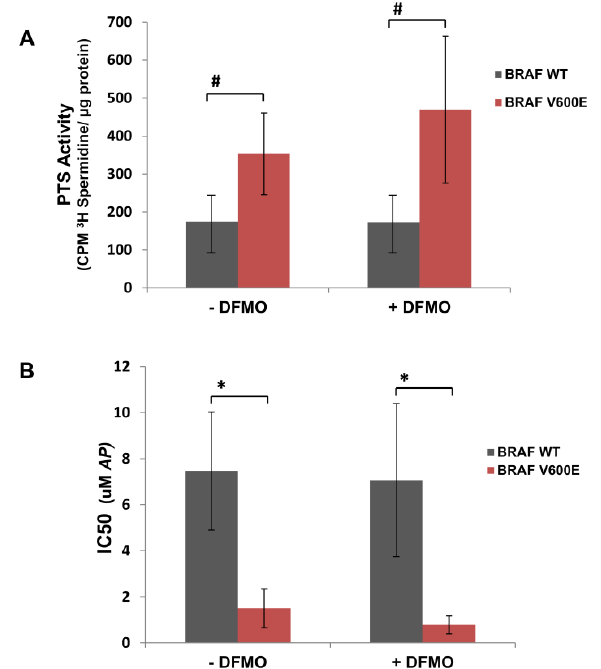
Figure 2. Greater PTS activity and increased sensitivity to AP in mutant BRAF V600E human melanoma cells compared to wild type (WT) BRAF WT cells. ( A ) BRAF V600E human melanoma cells (WM983B, WM3734, 1205Lu, WM989, and WM88) and BRAF WT human melanoma cells (WM3451, WM3743, and WM3211) were cultured with and without 1 mM DFMO for 40 h and then pulsed with 0.5 µ M 3 H-spermidine for 60 min at 37 ◦ C. Cell lysates were assayed for CPM 3 H-spermidine per mg protein by scintillation counting. The mean PTS activity ± SD for BRAF WT melanoma cells is compared with that of BRAF V600E melanoma cells under conditions where cells were cultured without added DFMO or with 1 mM DFMO. ( B ) BRAF V600E human melanoma cells (WM983B, WM3734, 1205Lu, WM989, and WM88) and BRAF WT human melanoma cells (WM3451, WM3743, and WM3211) were